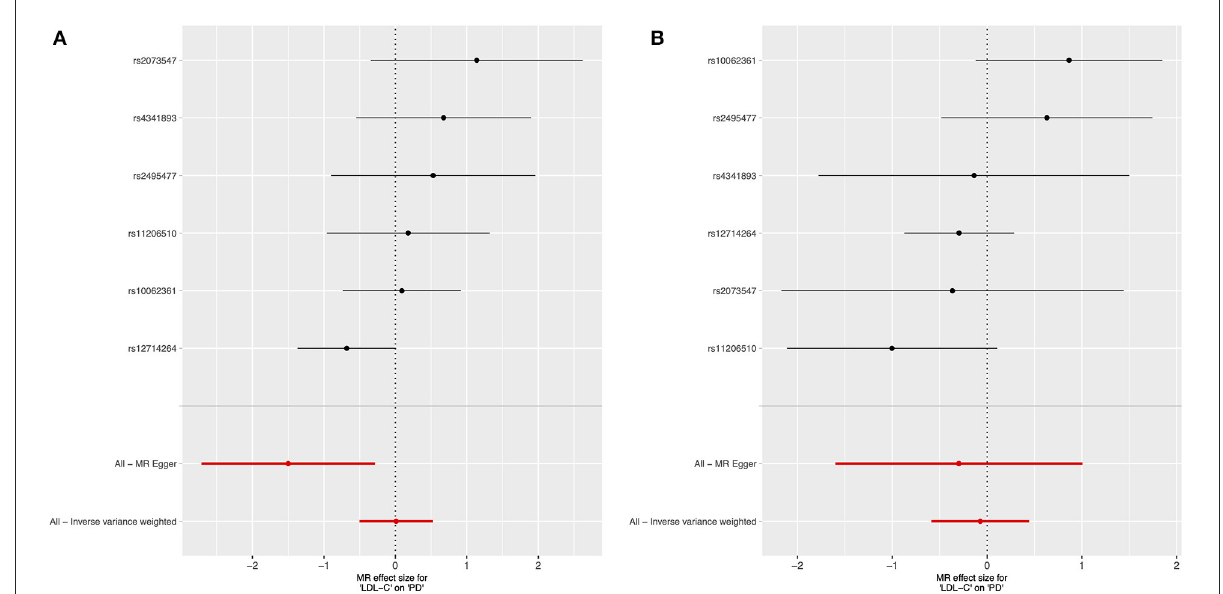
FIGURE1 Forest plot of sex-specific cis-Mendelian randomization results for the effect of circulating LDL cholesterol levels on risk of late-onset Parkinson’s disease. Female-specific results presented in (A) , and male-specific in (B) .